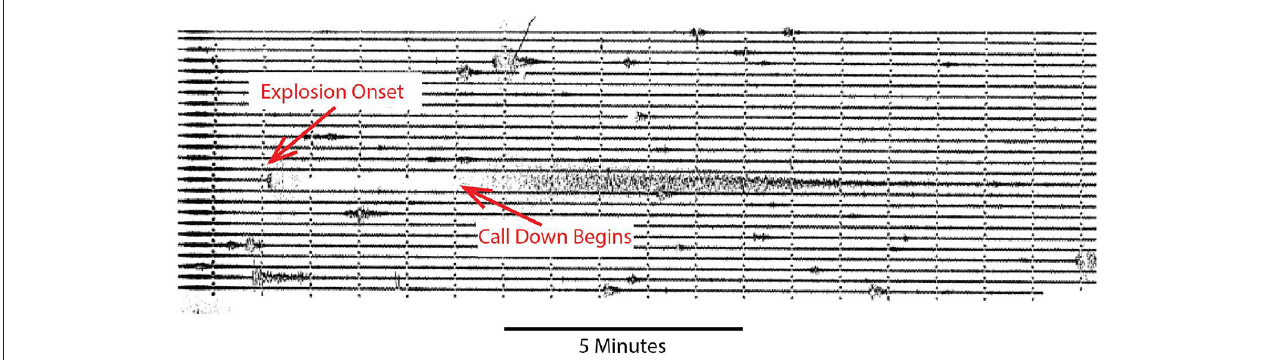
FIGURE 3 | A portion of a drum record for station RED ( Figure 2 ) from February 21, 1990 showing explosion at Redoubt Volcano at 09:32 UTC. Labels note relative onset time of explosion and recorded time AVO call down began. Time marks represent 1min intervals. In this case, response time was 4min after the explosions onset.